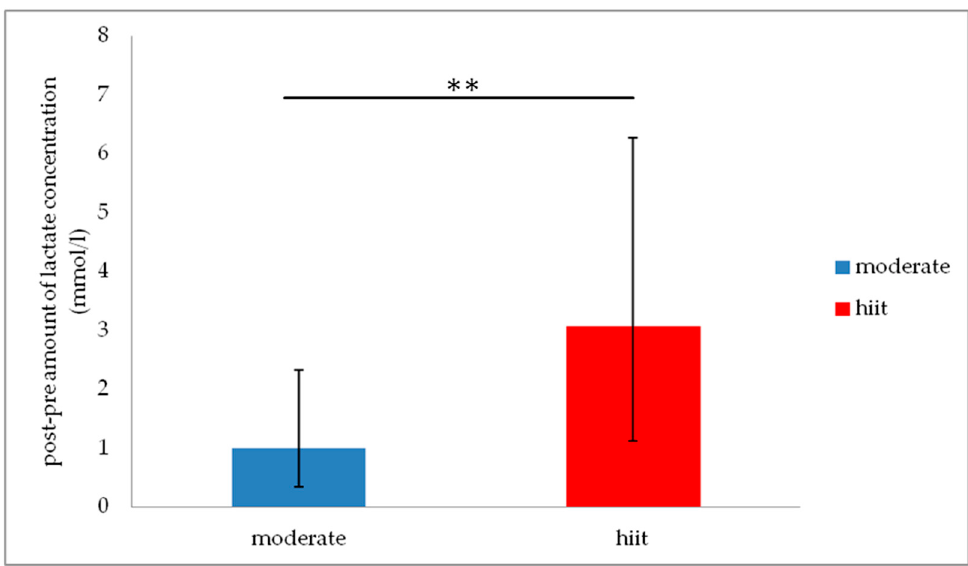
Figure 4. Amount of the blood lactate concentration post-pre-value (mmol/L) for moderate ( n = 26) and hiit ( n = 26) exercise condition, ** p < 0.001. Error bars represents the mean ± one standard deviation.